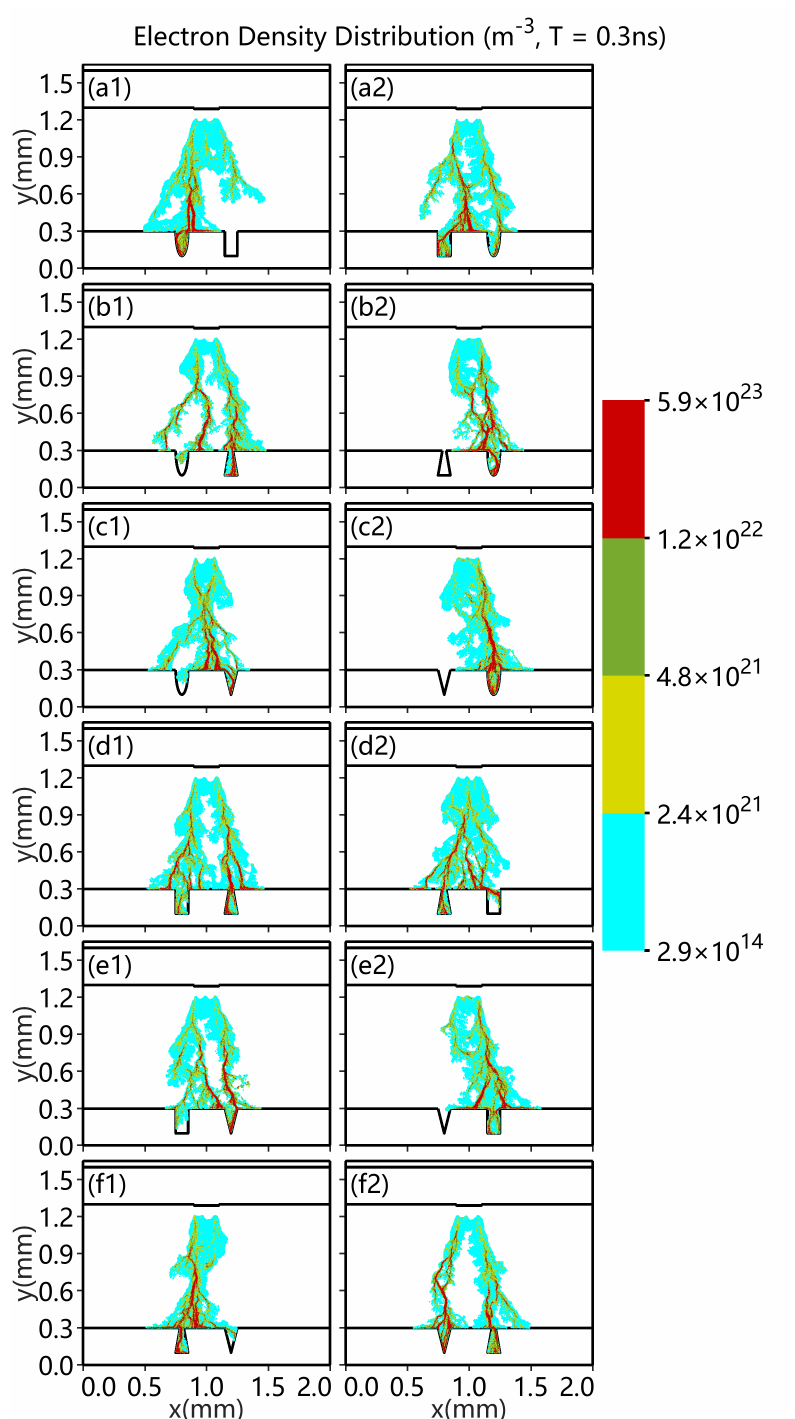
Figure 2. Electron densities (m − 3 ) of different catalyst pore shapes at 0.3 ns in DBD with ε r = 4 for both the top and bottom dielectric plates. The shapes of catalyst pores are ellipse and rectangle ( a1 , a2 ), ellipse and trapezoid ( b1 , b2 ), ellipse and triangle ( c1 , c2 ), rectangle and trapezoid ( d1 , d2 ), rectangle and triangle ( e1 , e2 ), trapezoid and triangle ( f1 , f2 ). The size of the catalyst pore is 0.2 mm in the depth direction. The voltage of the upper electrode ( y ∈ [ 1.60,1.65 ] mm) is − 20 kV, and the bottom electrode ( y = 0 mm) is